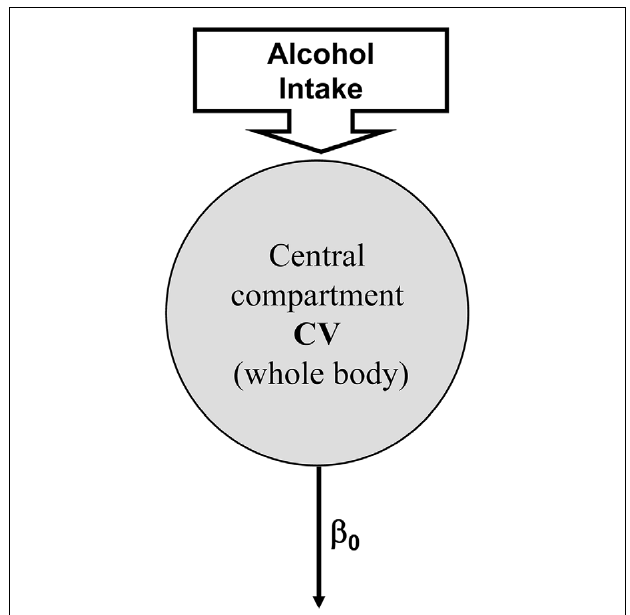
FIGURE 3 |Widmark’s zero-order model of ethanol kinetics.